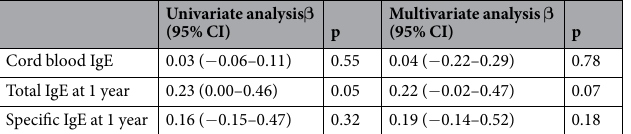
Univariate analysis β (95% CI) p